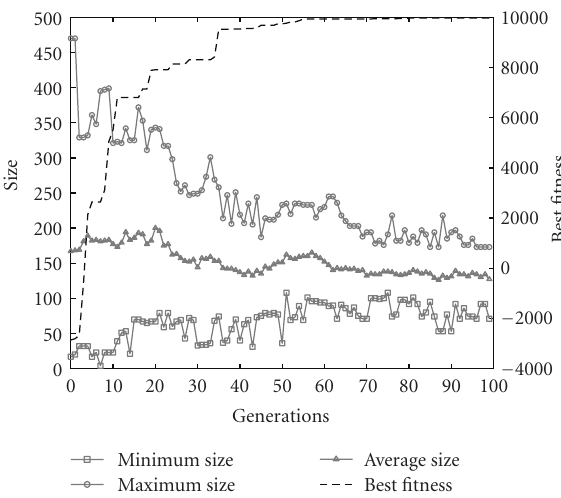
Figure 3: Symbolic regression Experiment 1: chromosome sizes and best fitness.